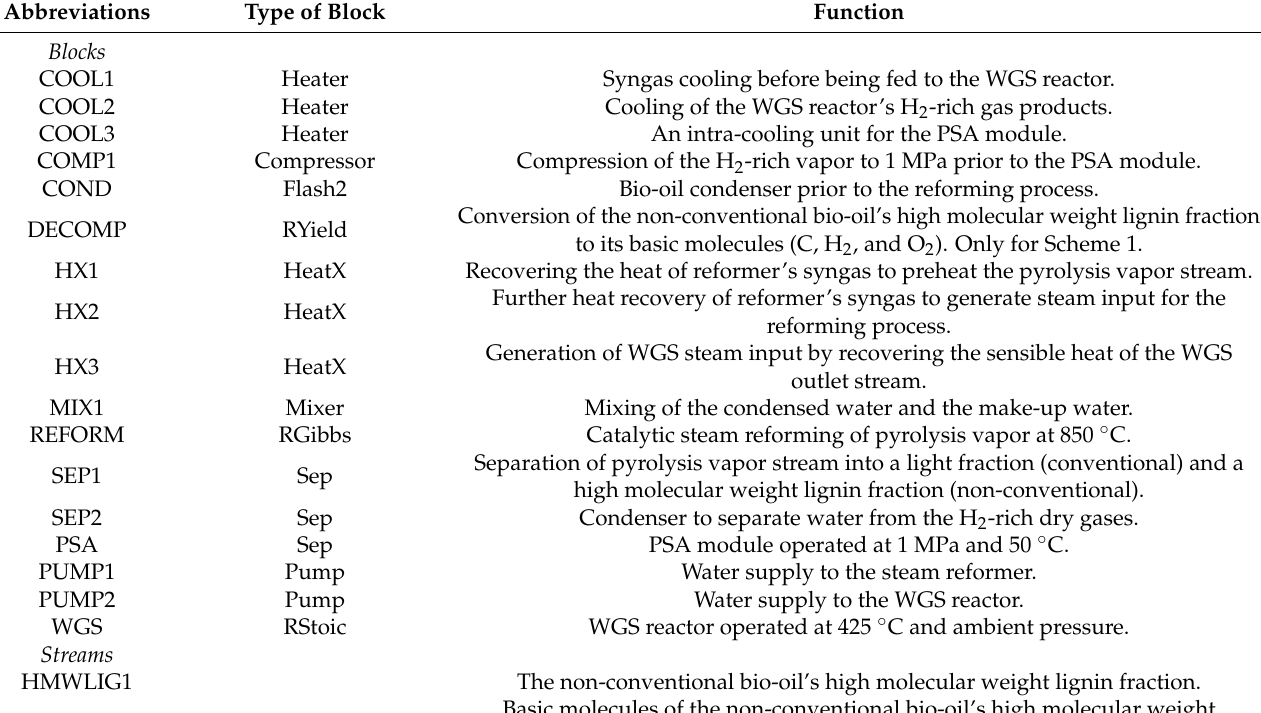
Table 6. Summary of blocks and streams used in the Aspen Plus